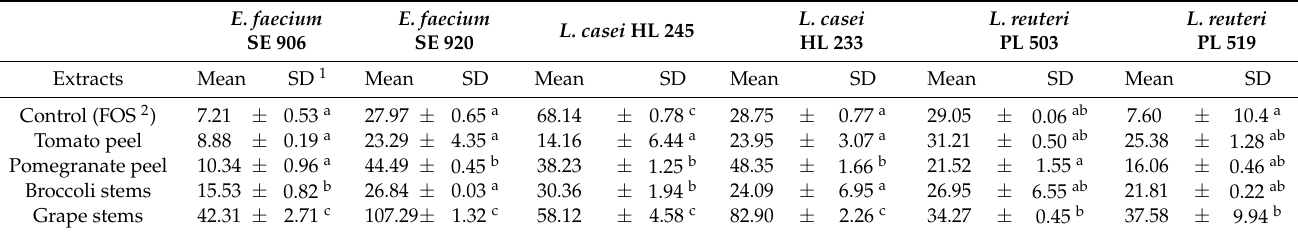
Table 3. Percentage growth of lactic acid bacteria (LAB) strains, with respect to the positive control, on soluble dietary fibre